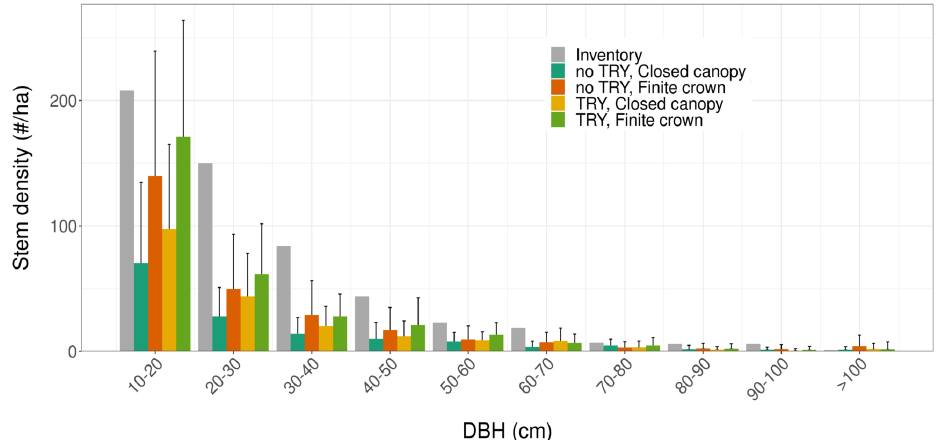
Figure 6. Tree size distributions for multiple model configurations starting from near bare-ground conditions after 100 years of simulations (coloured bars), and how they compare to the field inventory (grey). The histograms and the vertical error bars represent the mean ± one standard deviation of the ensemble member runs. Only runs that generated vegetation were kept when plotting this